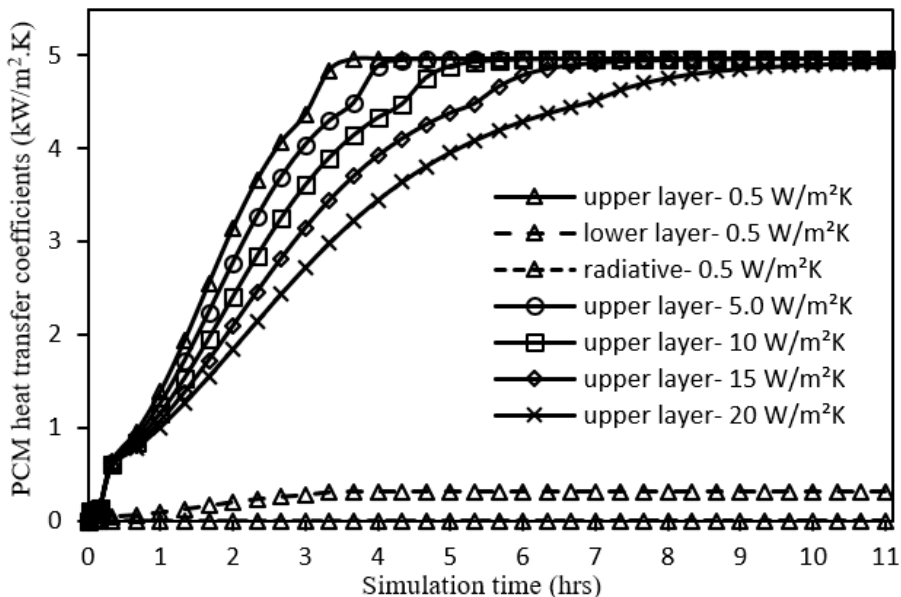
Figure 6. Average PCM temperature profiles for different metal foam convective heat transfer coefficients.